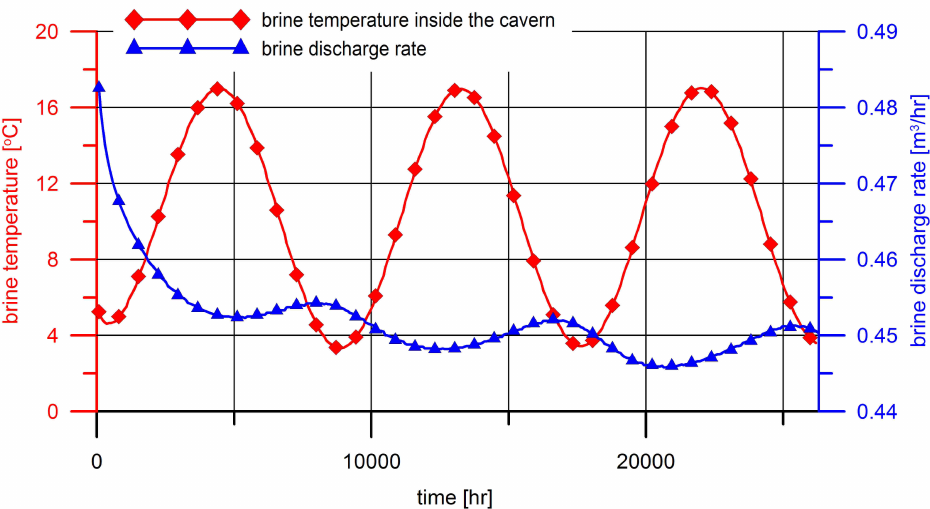
Figure 5. The temperature changes of the brine filling the cavern and the change of brine outflow in the model variant in which leaching begins in